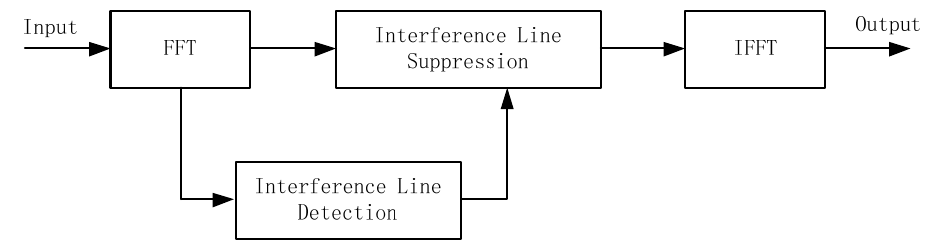
Figure 2. The basic principle of frequency domain anti-jamming. Figure 3. The suppression of narrowband interference is realized by setting the interference spectral line to zero.